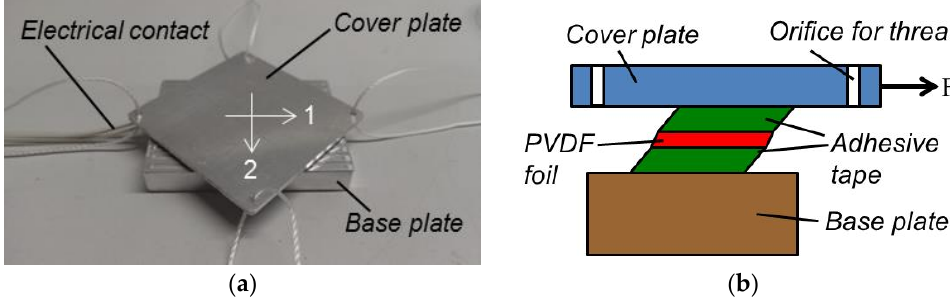
Figure 6. Set up for measuring the voltage generated by shearing a PVDF foil as a photo with 1- and 2-direction marked ( a ) and a schematic drawing ( b ) (not to scale).